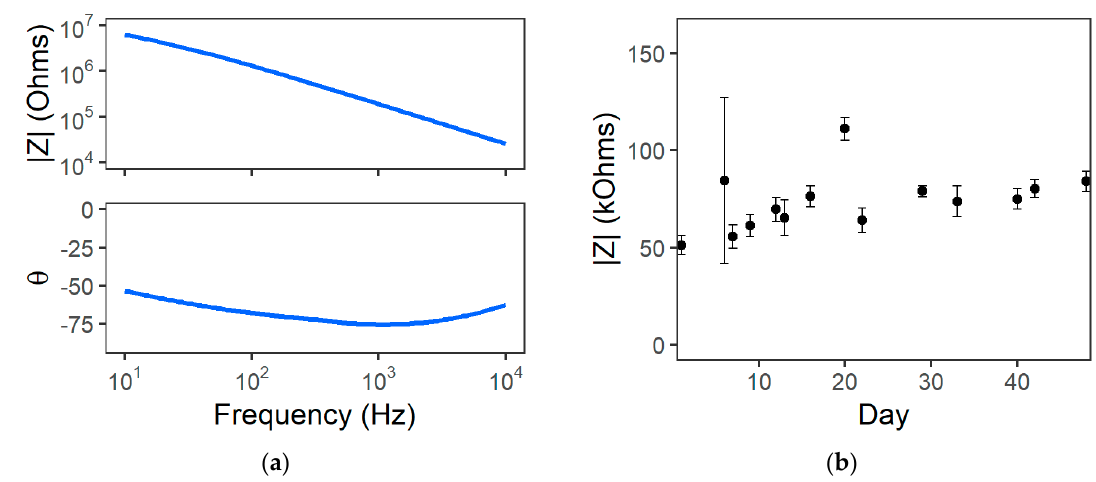
Figure 6. Representative results from PVAc-CNC soak testing with 50 µm-diameter microelectrodes: ( a ) Impedance spectra at 1 h after immersion in PBS; ( b ) Impedance magnitude at a 1 kHz frequency over time.